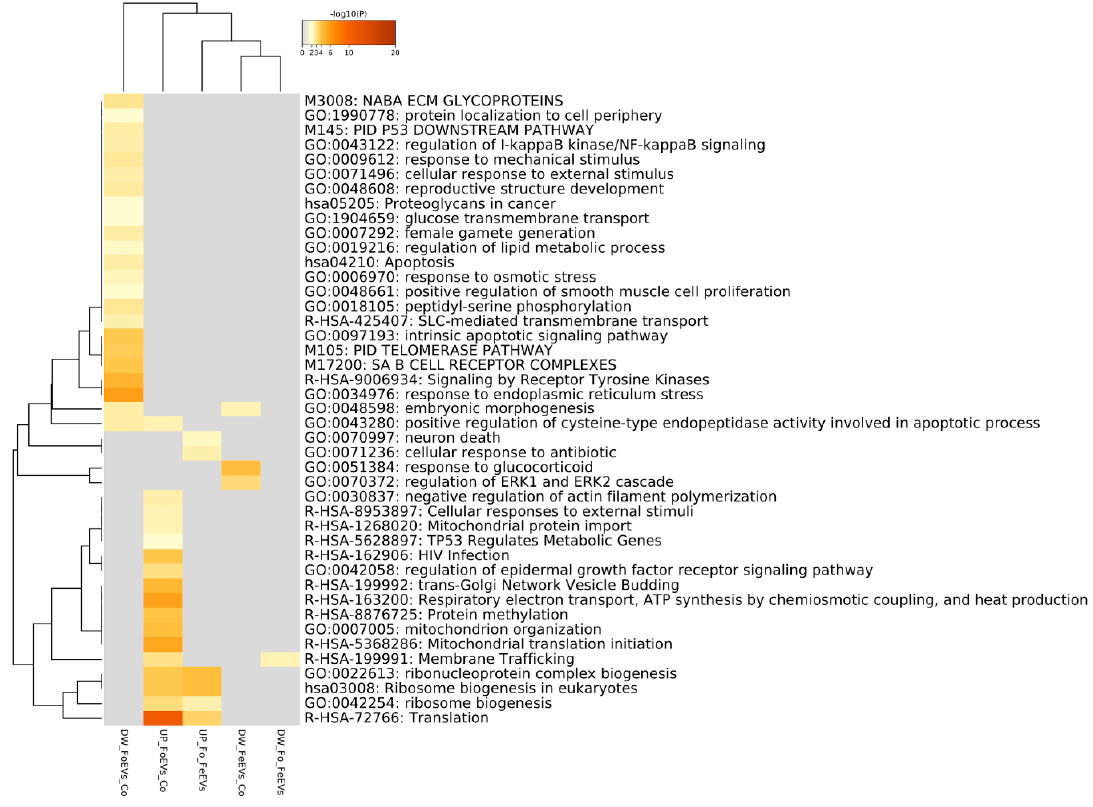
Figure 3. Functional enrichment analysis for up- and downregulated genes in embryos treated with FoEVs or FeEVs compared to control and between oEV treatments using Metascape tool. Bar graph of enriched terms across DEGs colored by p -values representing enriched clusters up to a score of 2.